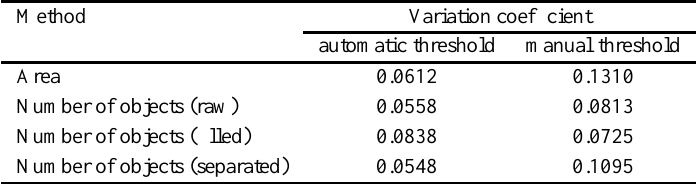
Variation coefficients for different stages of the proposed method, using auto- matic and manual